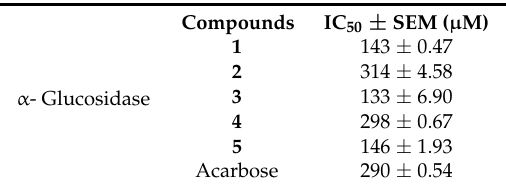
Table 1. Half-maximal inhibitory concentrations of test compounds ( 1 – 5 ) isolated from Dryopteris